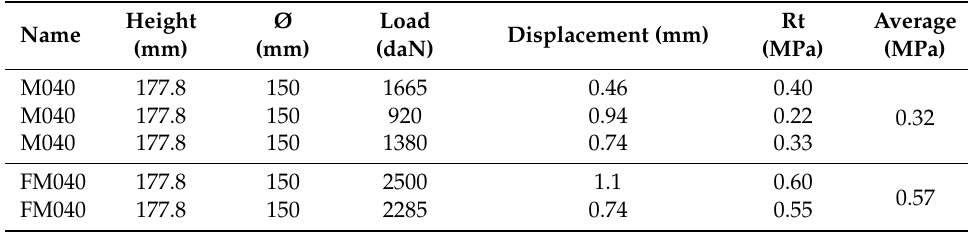
Table 2. Indirect tensile strength (ITS) results.